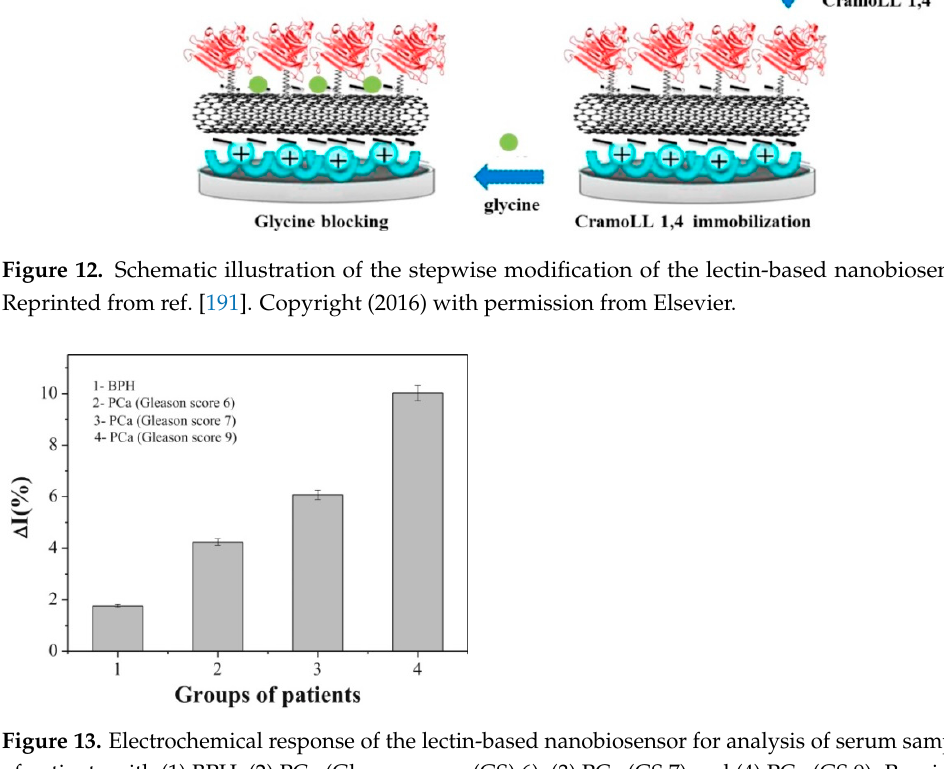
Figure 14. Selective glycoprotein detection using boronate-based imprinting approach. Strategy for the fabrication of glycoprotein-imprinted surfaces using acrylamido-boronic acids (AM-BAs); ( 1 ) self-assembled monolayer (SAM) formation on a gold surface with DFC molecule; ( 2 ) incubation of the AM-BA receptors with the template target glycoprotein; ( 3 ) grafting of the preformed boronic acid–glycoprotein complex on the SAM via acrylamide co-polymerization; ( 4 ) azide-terminated ol- igoethylene glycol (Az-OEG) functionalization to provide glycoprotein-shaped cavities; ( 5 ) removal of the template protein, affording a nanocavity specific for the target glycoprotein. Reproduced from ref. [192] under a Creative Commons Attribution License. Although a dual-recognition strategy for increasing the selectivity of glycoprotein detection using two types of MIPs was designed for the detection of a carcinoembryonic